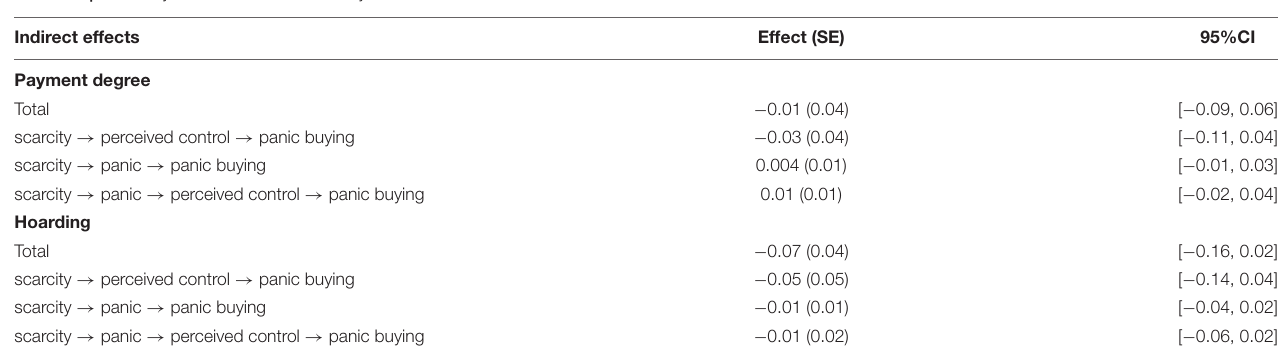
TABLE 7 | Summary of indirect effects in study